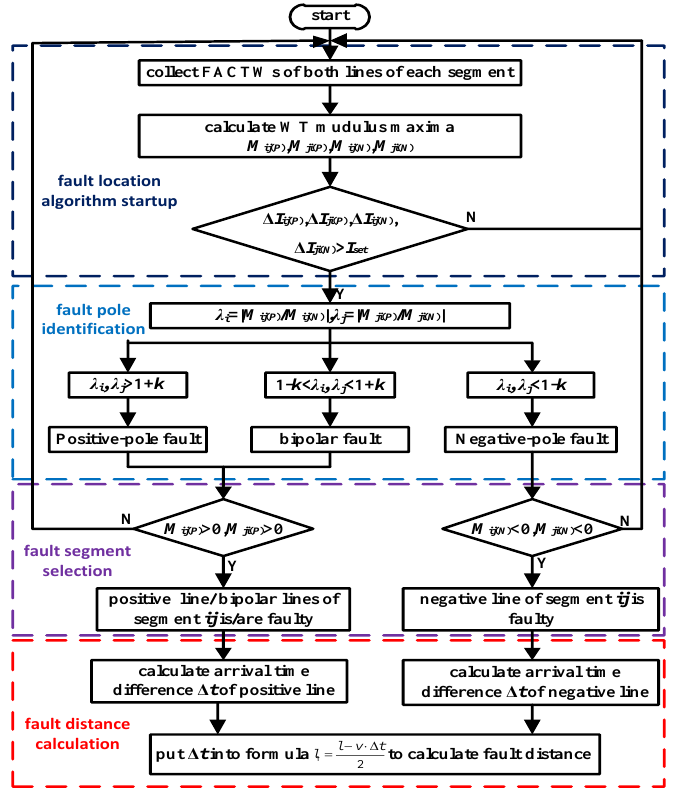
Figure 8. Block diagram of the proposed fault location scheme.